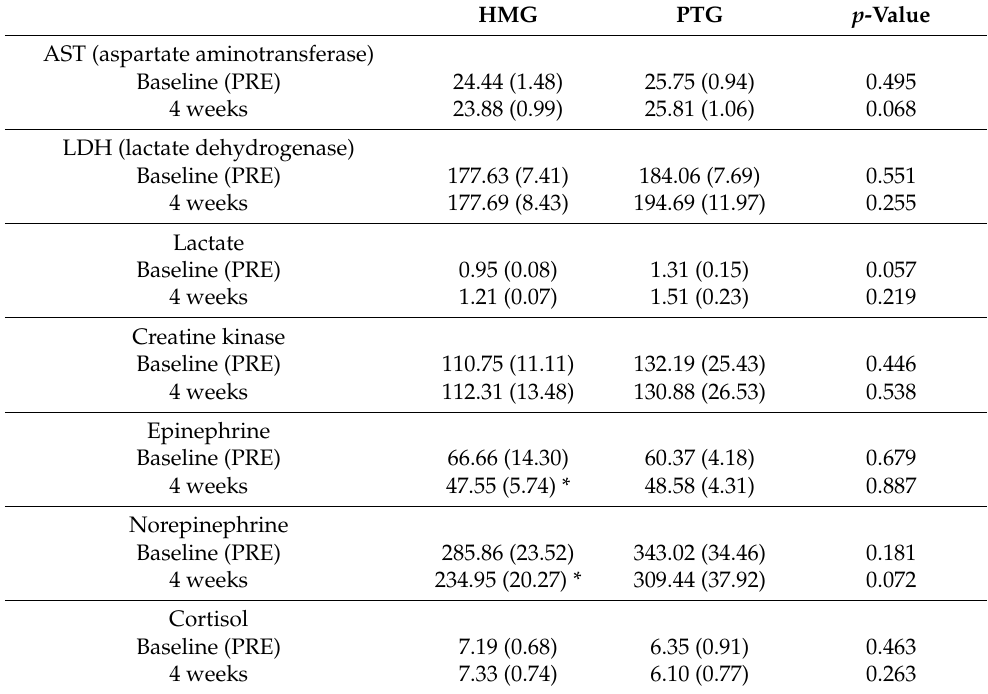
Table 3. Comparison of the blood sample tests.